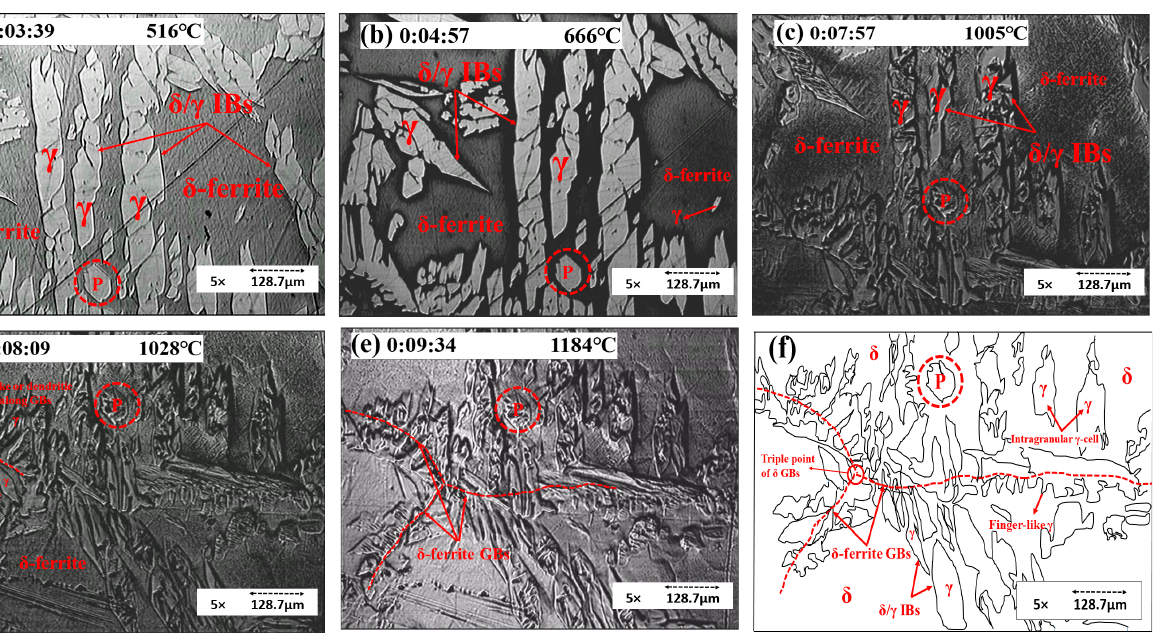
Figure 5. Concentric HTCM images revealing ( a – c ) the morphology changes of the γ phase and ( d – f ) the growth of δ / δ GBs; ( f ) a schematic diagram of the γ morphology of S32101 DSS. As the temperature increased, γ fully transformed to δ , and δ GBs showed up. In Figure 6, the red dotted line represents the δ / δ GBs, while the white dotted line represents the solid/liquid IBs. In frame (b), a new δ GB showed up; after the growth of new δ GBs, the sample started melting, as shown in frame (c). The liquid phase in frame (d) was located along the δ